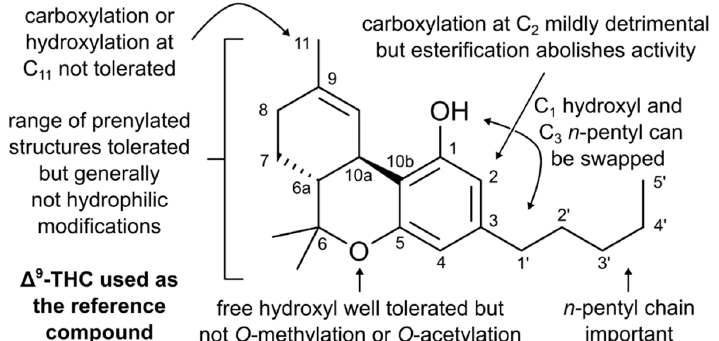
Figure 2. Summary of cannabinoid structure–activity relationships. Please note that this is a rough guide and the conclusions drawn therein are only relevant to antimicrobial activity against Gram-positive pathogens such as S. aureus.